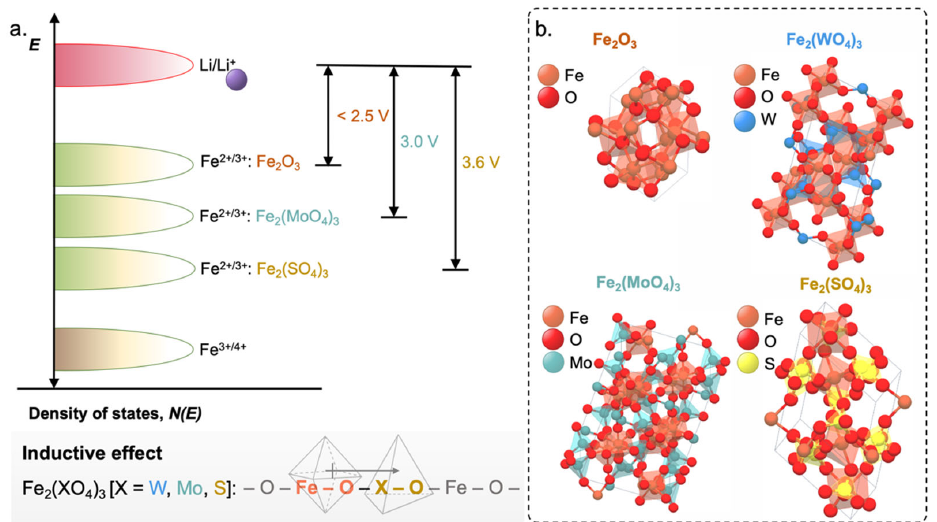
Figure 5. Rationale for polyanion compounds as cathode materials: ( a ) role of counter ‐ cations in altering the redox energies in polyanion oxides as exhibited by inductive effect–polarization of the O 2 − electrons into the strong covalent bonding within the polyanion reduces the covalent bonding to the Fe ‐ ion which consequently lowers its redox energy (Adapted from [5]); ( b ) crystal structures [41] of simple oxide Fe 2 O 3 and Fe ‐ polyanion oxides.